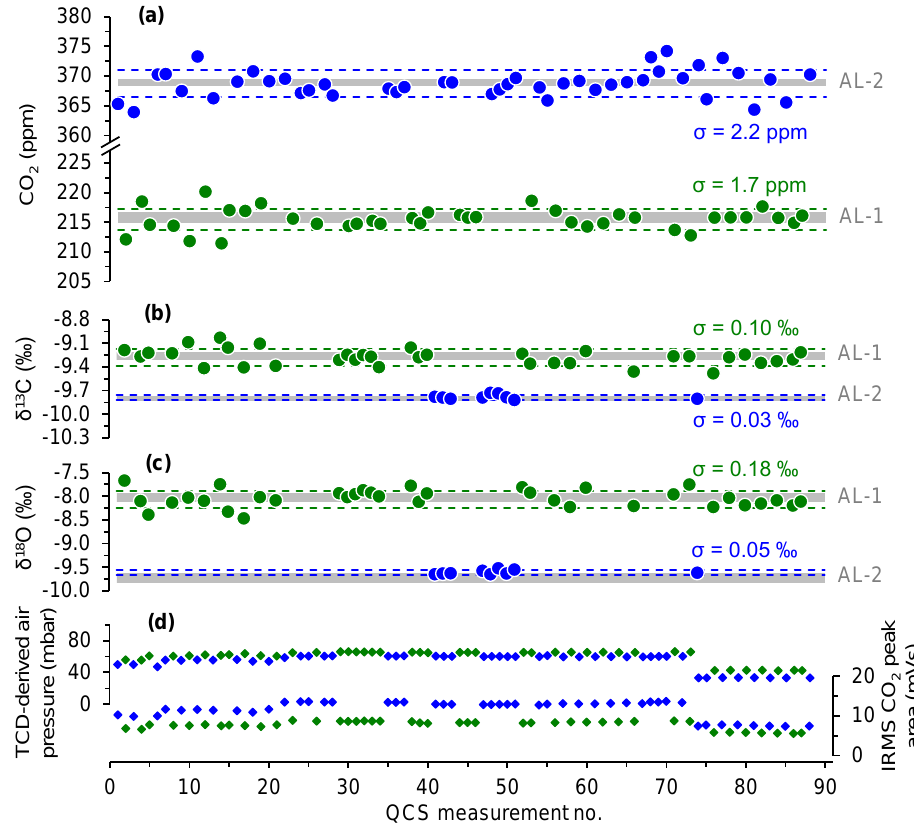
Figure 6. Repeated quality control sample (QCS) measurements of air standards AL-1 (in green) and AL-2 (in blue) over ice, covering a time period of 2 years. The grey bands indicate the assigned value of the standard with uncertainty as given in Table 2. Dashed lines indicate the 1 σ standard deviation of the data points (see numerical values). (a) CO 2 mixing ratios (ppm). (b) δ 13 C-CO 2 (‰ VPDB). (c) δ 18 O-CO 2 (‰ VPDB-CO 2 ) . (d) Injected amount of air (top, left axis) and related amount of CO 2 (bottom, right axis). Fewer results are shown for the stable isotopes because standards used in the daily calibration routine (i.e. not post-processed similar to real samples) were excluded from this